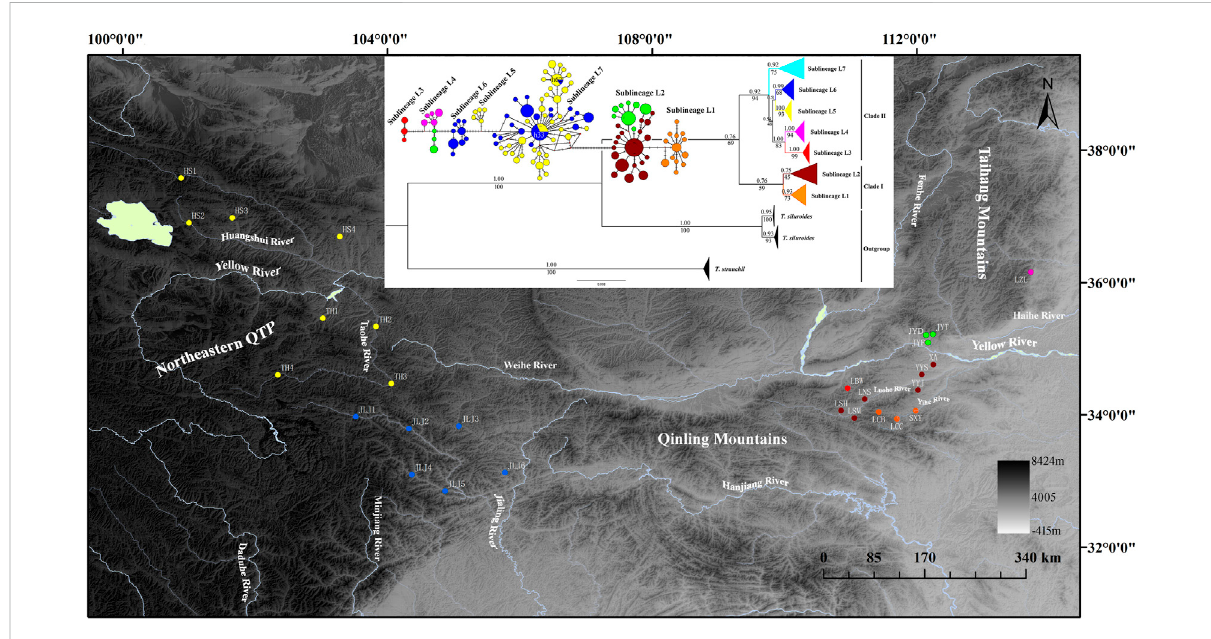
FIGURE 1 Map of sampling locations of T. robusta , localities are detailed in Table 1 according to Wu et al. (2020) and Feng et al. (2019), and the phylogenetictreebasedonBayesianinference(valuesonbranchesindicatebootstrapproportionsfromamaximumlikelihoodanalysisandbayesian posterior probabilities), and the median-joining haplotype network based on 235 cytb sequences, the size of the circles represents haplotype frequency. Each connecting line represents a single nucleotide substitution, and each little short line represents a mutated position. Different river systems were represented in different colors, consistent with the colors of the